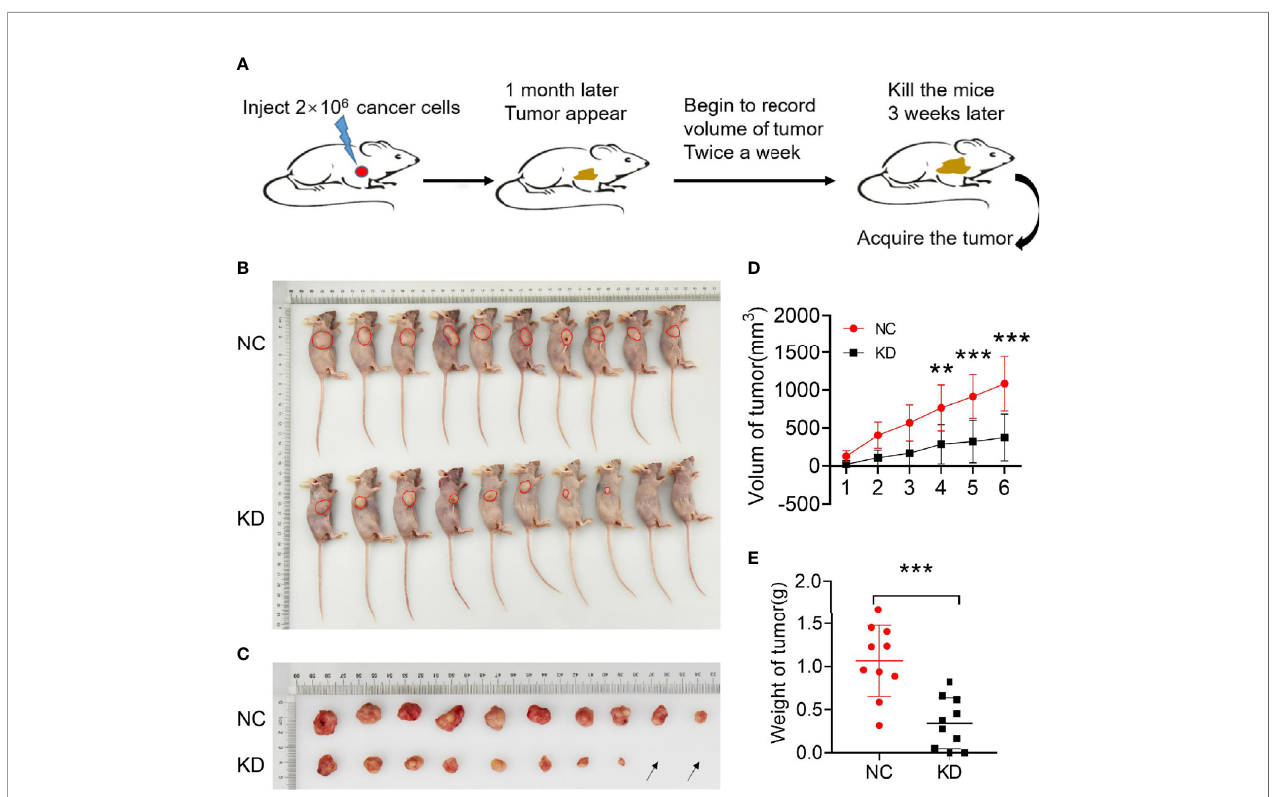
FIGURE 4 | Experiments on animals were conducted to verify the effect of B4GALNT2 gene knockdown of MDA-MB-231 breast cancer cell line on the proliferation of breast cancer cells in-vivo . (A) Model diagram of the mouse experiments. (B) Subcutaneous construction of tumor model in nude mice (each nude mouse was inoculated with 2×10 6 tumor cells). (C) Nude mice tumor size; the black arrow indicates that there was no lump formation. (D) Tumor growth curves. (E) Statistical comparison of the weight of tumors in the two groups of nude mice. Note: NC=normal control; KD=knockdown of the B4GALNT2 gene. ***p < 0.001, ****p <